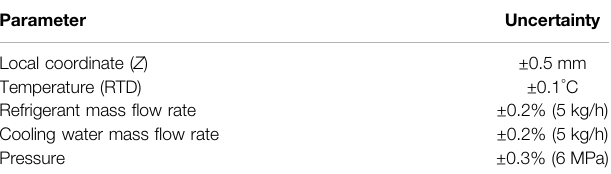
TABLE 2 | Uncertainties of the measured